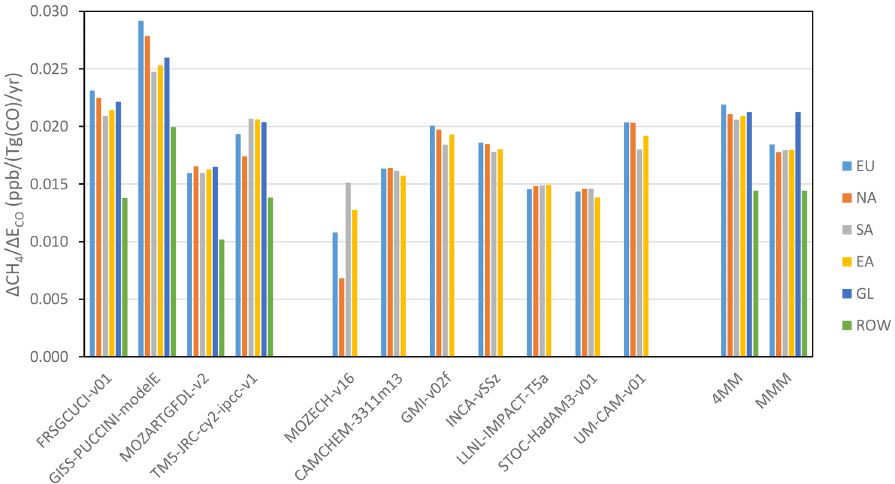
Figure 3. As in Fig. 2 but showing methane sensitivities for changes in surface anthropogenic CO emissions (Tg(CO)yr − 1 ).